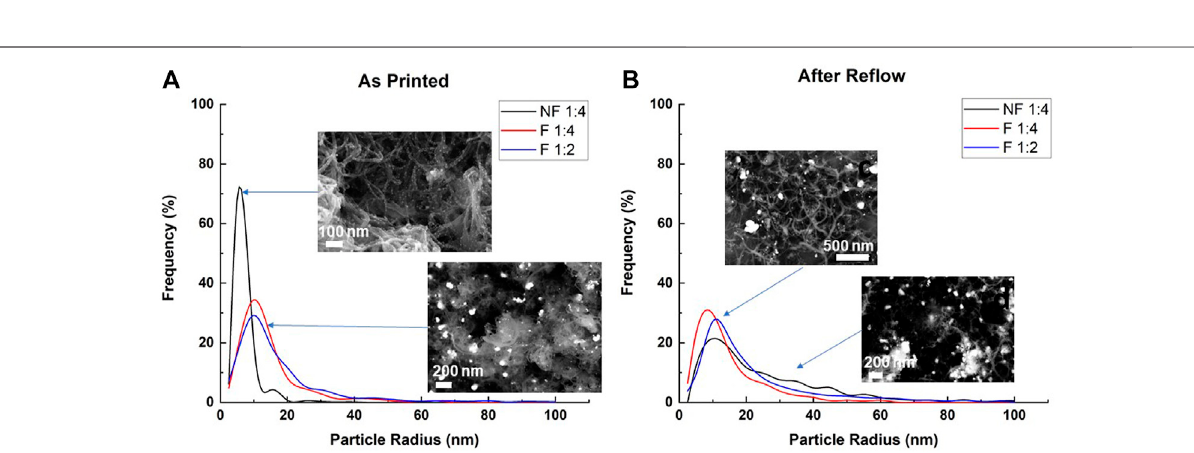
Frontiers in Materials |